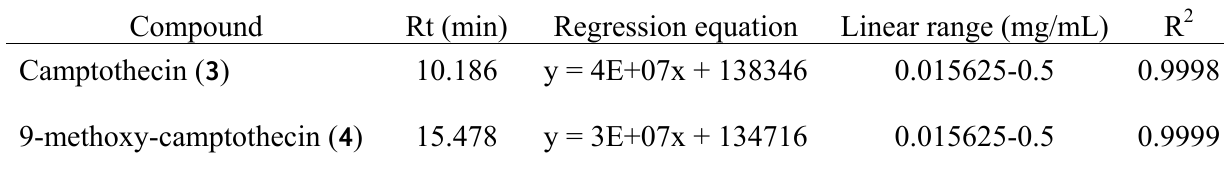
Table 2. Regression equations and retention times of compounds 3 , 4 determined for the HPLC assay.